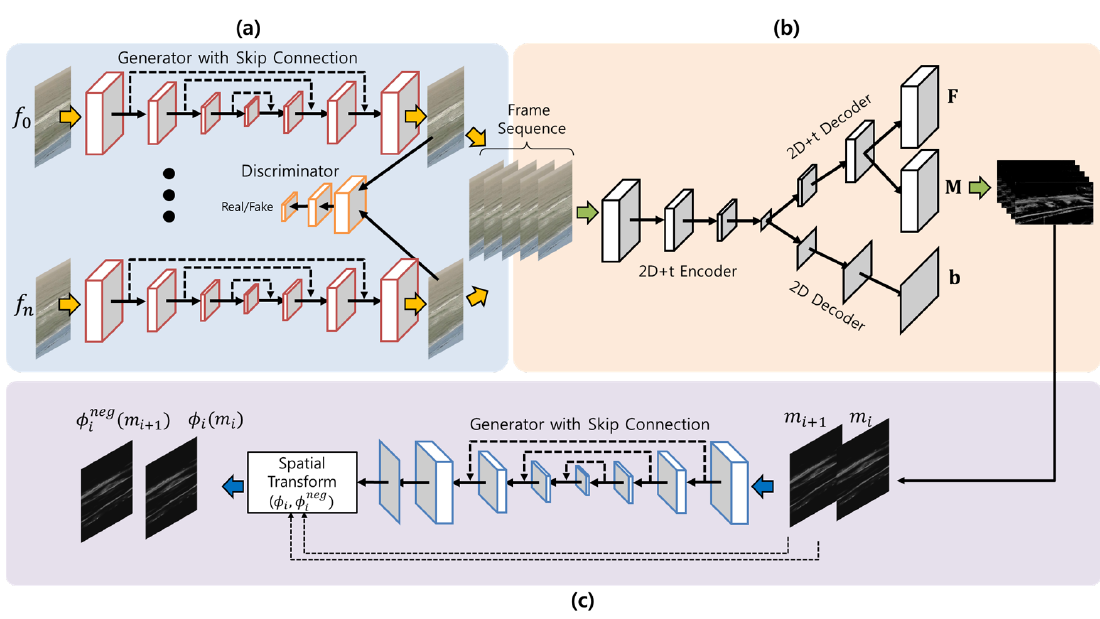
Figure 2. The architecture of the proposed deep neural networks consisting of three parts: ( a ) video enhancement, ( b ) hydrodynamic scene separation, and ( c ) unsupervised image registration. For the Pix2Pix network pre-training, we use an open dataset including paired images with and without raindrops in the land environment collected by Qian et al. [9]. After the pre-training, we train the pre-trained model using a dataset paired with and without raindrops, which was acquired directly using two CCTVs installed side by side in Anmok beach [10]. 17,002 paired images are extracted from the 10 min. long video clips. 12 video clips classified with raindrop patterns were used to fine-tune the transferred pre-trained Pix2Pix network parameters of which some samples are shown in the Figure 3.